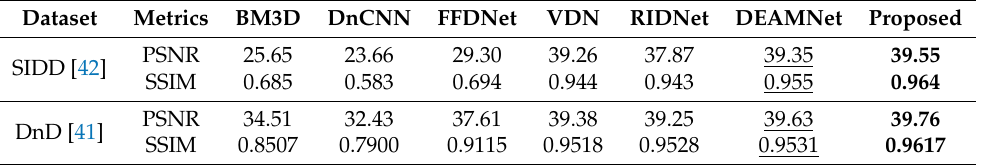
Table 2. Real-image denoising results of several existing methods on SIDD and DnD dataset. Top results are in bold, and second best results are underlined.